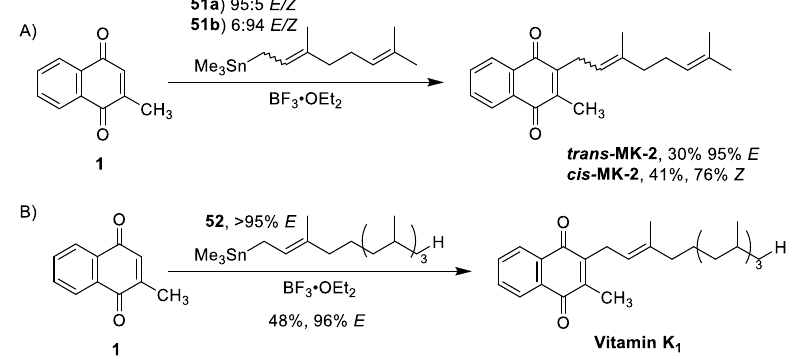
Table 7. Summary of electrophilic ring